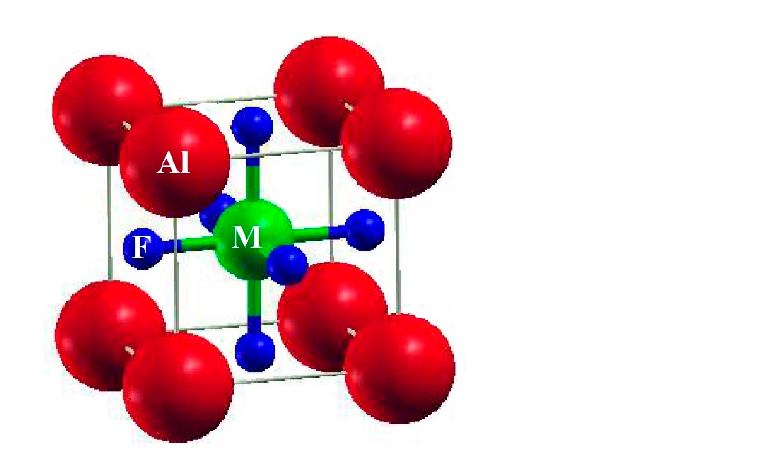
Figure 1. Figure represents the AlMF 3 (M = Cr, B) fluoroperovskite unit cell structure.